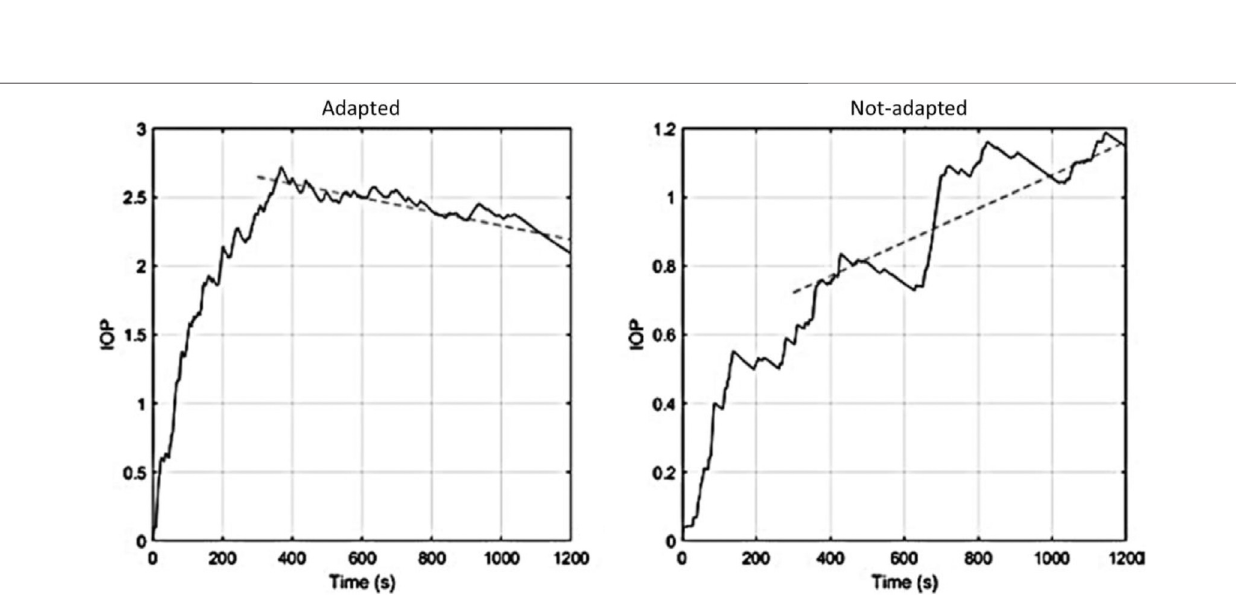
Frontiers in Virtual Reality |